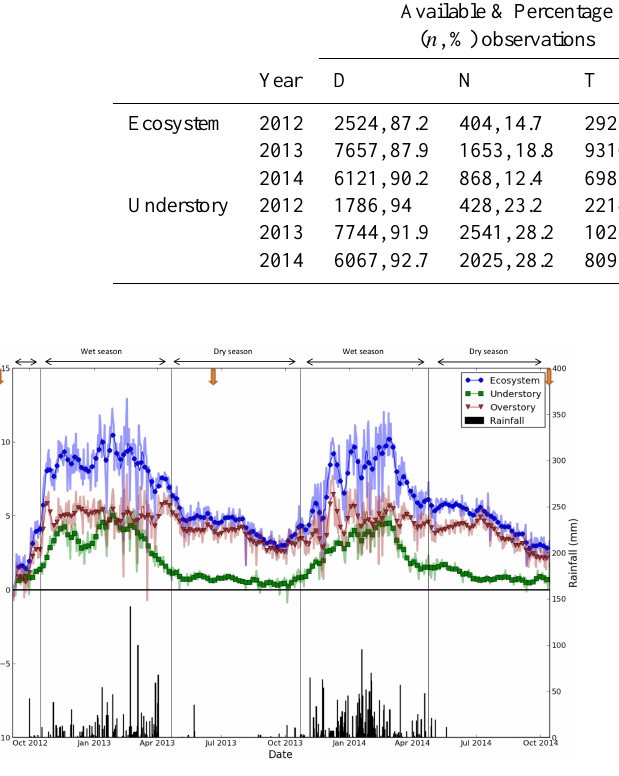
Figure 5. Gross Primary Productivity (GPP) for savanna ecosys- tem (23m tower), understory (5m tower) and overstory (difference between 23 and 5m towers) components at the Howard Springs OzFlux site, Northern Territory, Australia from September 2012 to October 2014. Data shown are daily GPP totals with a 10-day run- ning mean to aid visualisation. Orange arrows represent the timing of fire events. Positive fluxes indicate a net sink of carbon to the savanna whereas negative fluxes are a net source of carbon to the atmosphere. Rainfall is also included as daily